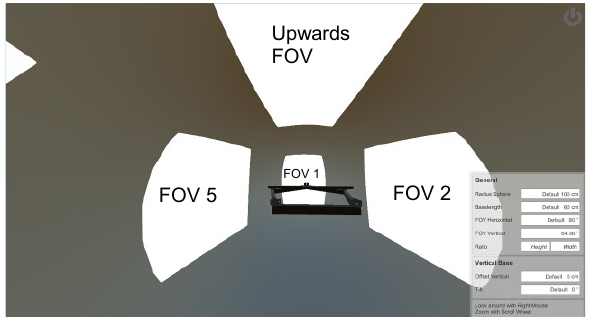
Figure 2. Depth coverage tool with the UI (right), here the FOVs are not